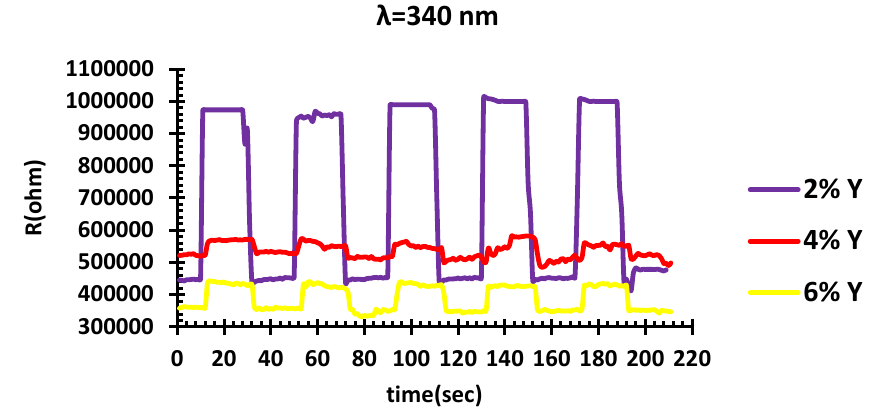
Fig. 6: Photo response time of the prepared undoped and doped Co Photo sensor upon exposure to 340 nm